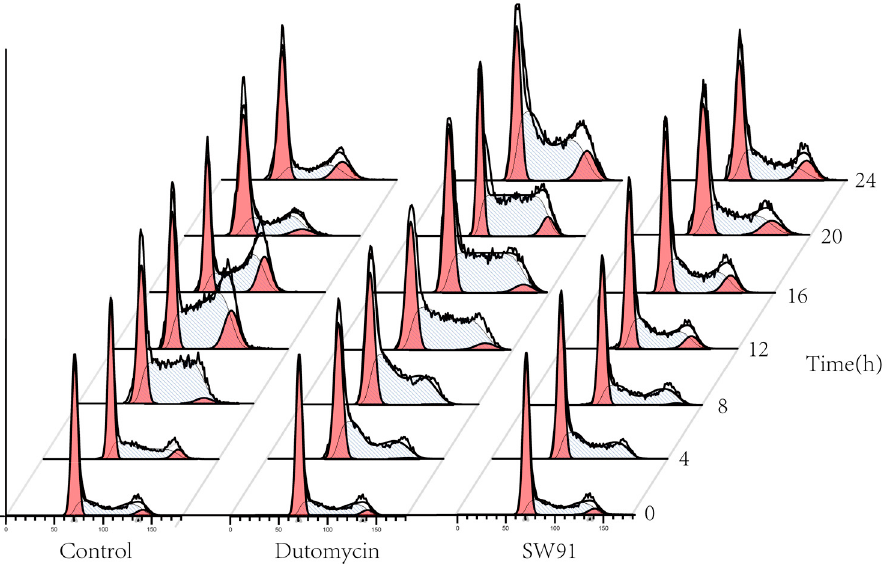
Figure 4. Graph of cell cycle changes for different compounds over time.